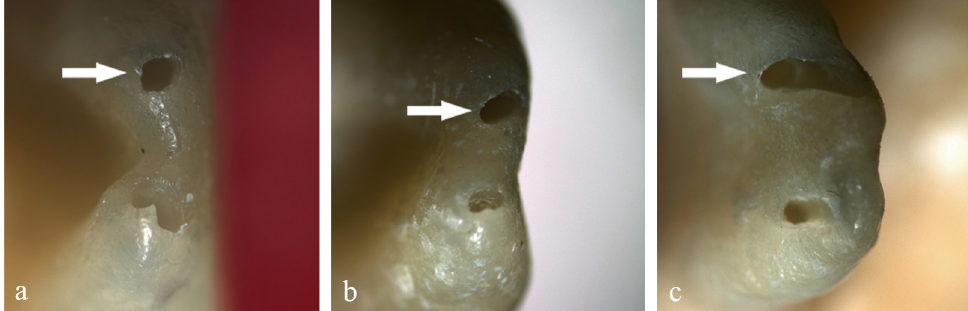
Figure 1- Apical foramen configuration examples after mechanical preparation using different techniques and working lengths (a- circular, b- oval, c- deformed)